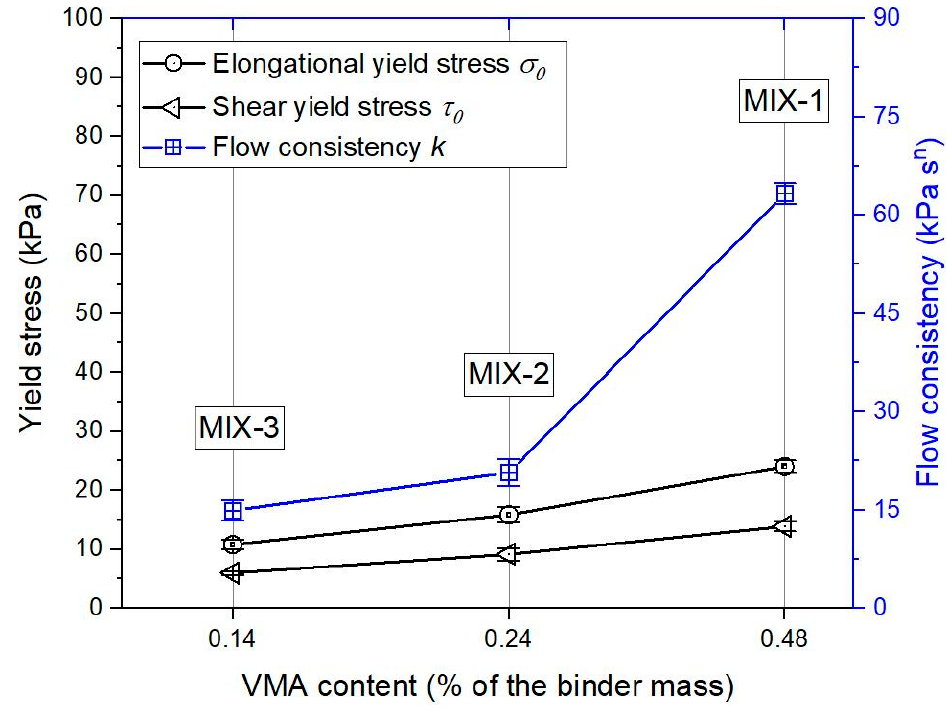
Figure 11. Fitted results of the elongational yield stress σ 0 and flow consistency k . Shear yield stress τ 0 was obtained by the Von–Mises criterion Equation (3). The RSD of σ 0 , k , and τ 0 was under 12%.